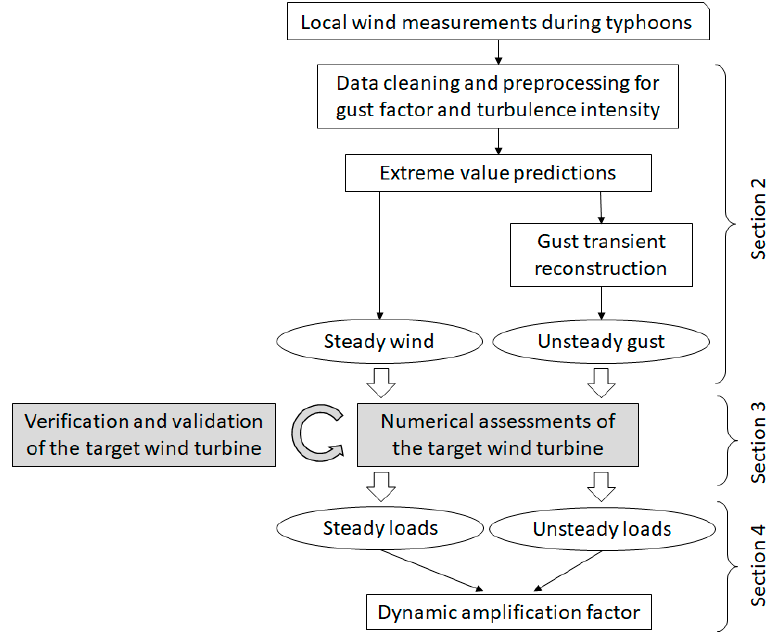
Figure 1. Framework of this study.